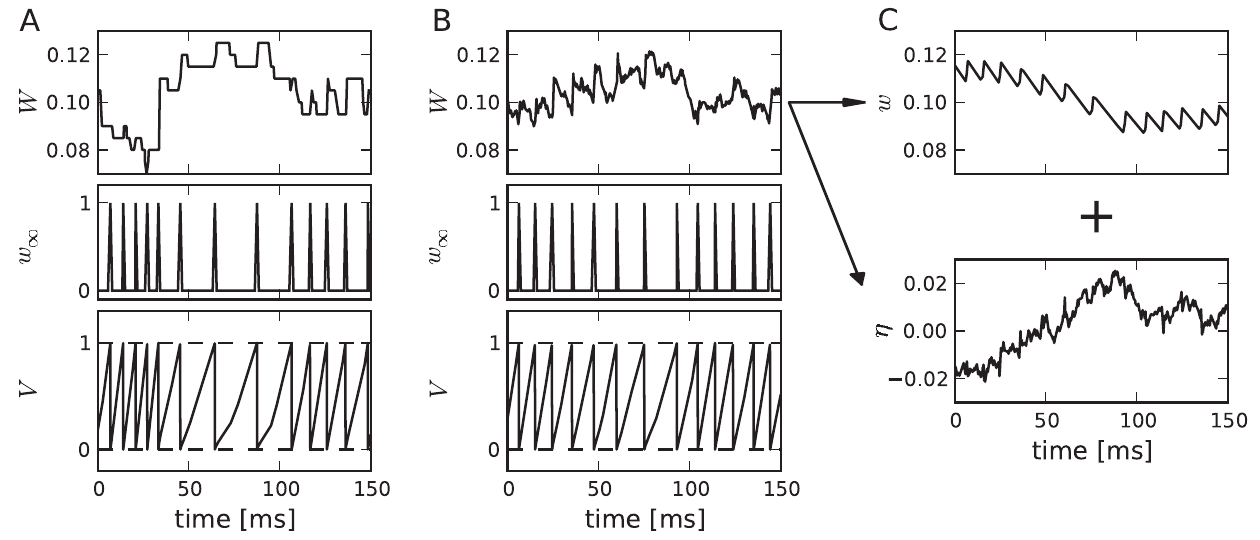
Figure 2. Diffusion approximation of adaptation current. A Sample traces of the integrate-and-fire dynamics with two-state adaptation channels, Eq. (20), (35) ( N a ~ 200 and D ~ 0 ). The fraction of open channels W (top) exhibits discontinuous jumps with directions that depend on the presence or absence of a spike as given by the activation function w ? ( t ) (middle panel). B Sample traces of the diffusion model, Eq. (1), with the same 1st and 2nd infinitesimal jump moments of W as in the channel model ( A ). C The fraction of open channels W can be split into the deterministic part w ( t ) , Eq. (1b), corresponding to N a ? ? , and an Ornstein-Uhlenbeck process g ( t ) , Eq. (1c), with a correlation time equal to the adaptation time constant (colored noise). The parameters are m ~ 0 : 4 V th = ms , b ~ 3 V th = ms , t w ~ 100ms